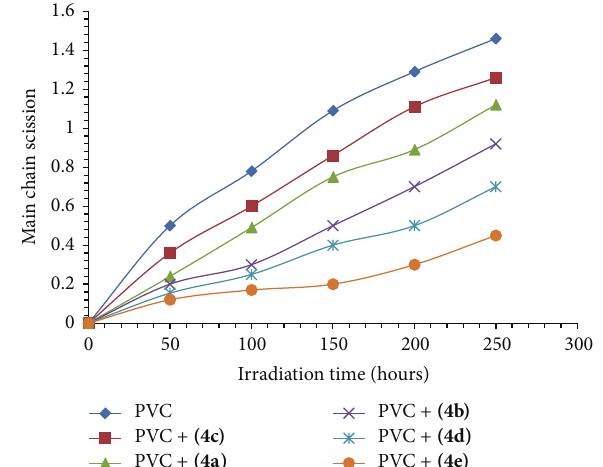
Figure 7: Changes in chain scission ( N ) during irradiation of PVC films (30 𝜇 m) containing 4a–e (0.5% by weight) or no additive.